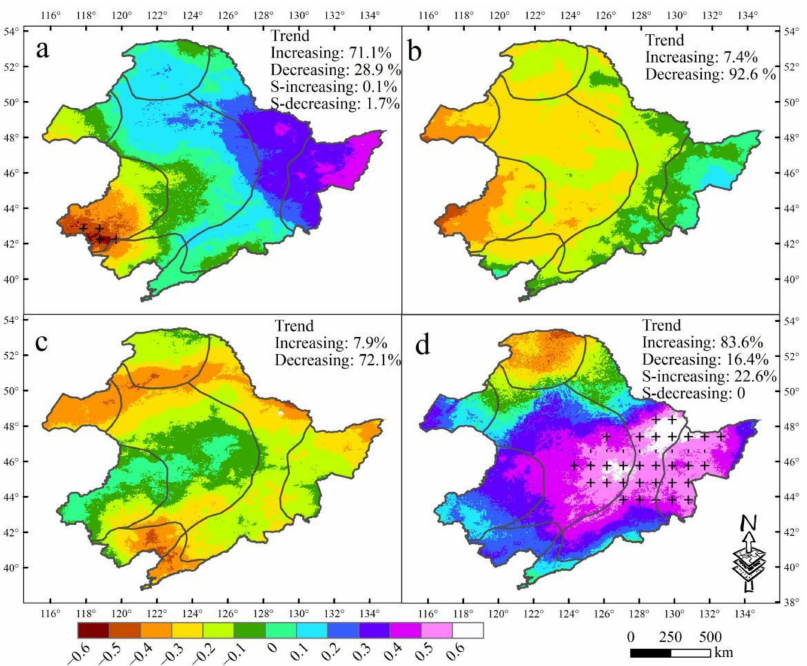
Figure 10. Spatial distribution of quarterly trends in spring ( a ), summer ( b ), autumn ( c ), and winter ( d ) based on SPEI03 in northeast China (NEC) from 1990 to 2018.